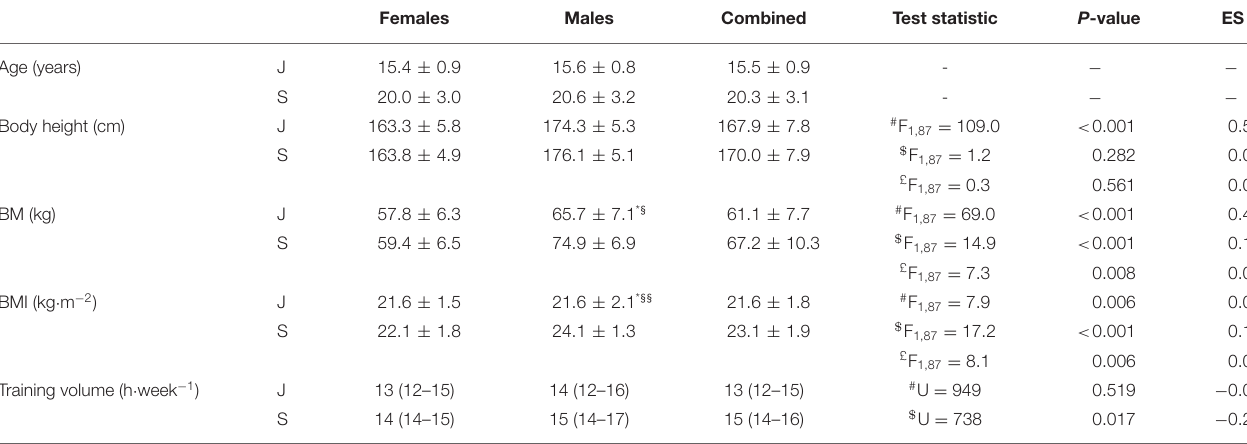
TABLE 1 | Participant characteristics for junior female ( n = 26), senior female ( n = 23), junior male ( n = 19), and senior male ( n = 23) TeamGym athletes presented as mean ± standard deviation (SD) with the exception for training time that is presented as median and interquartile range.